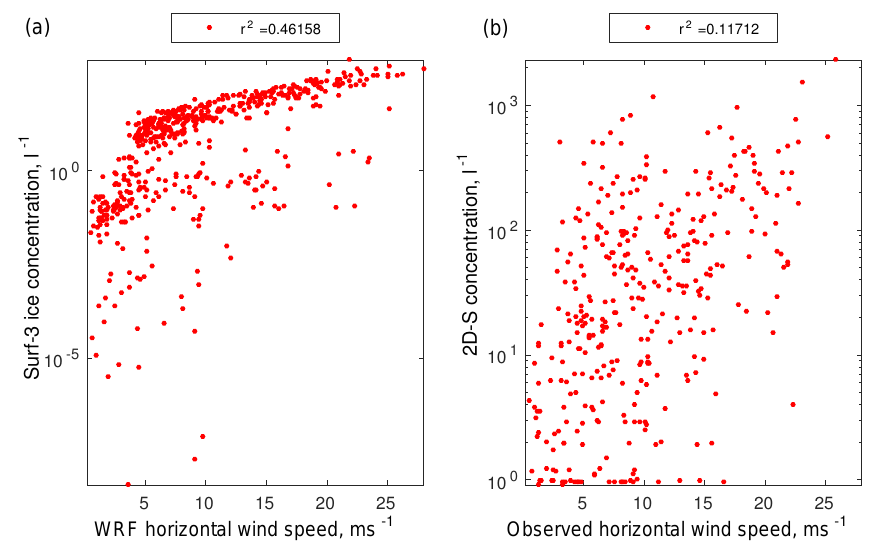
Figure 15. A comparison of the wind simulated in the Surf-3 simulation with (a) the ice crystal concentration simulated in the Surf-3 simulation at Jungfraujoch, and (b) the 2D-S ice crystal concentration at